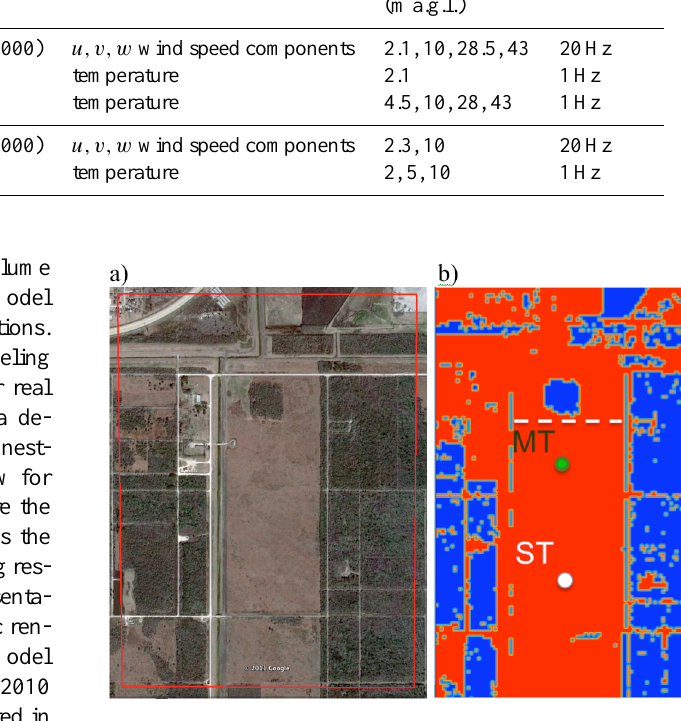
Fig. 2. (a) Aerial picture of the FireFlux area with the domain boundary marked in red; (b) “land use” field from WRF input (red signifies grassland; blue signifies mixed forest) with locations of main tower (MT; green dot), short tower (ST; white dot), and igni- tion line (white dashed